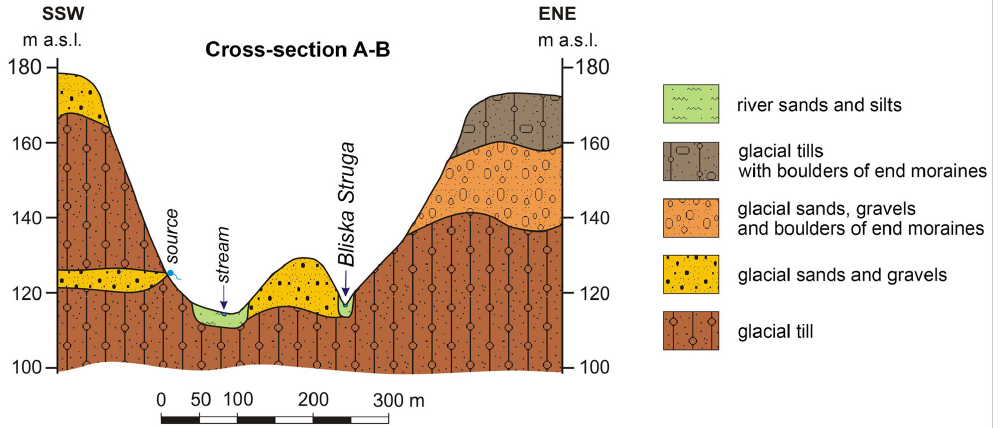
Fig. 4. Geological cross-section through the ravine of the bliska Stream and its tributaries acc. to kamieńska, Giemza